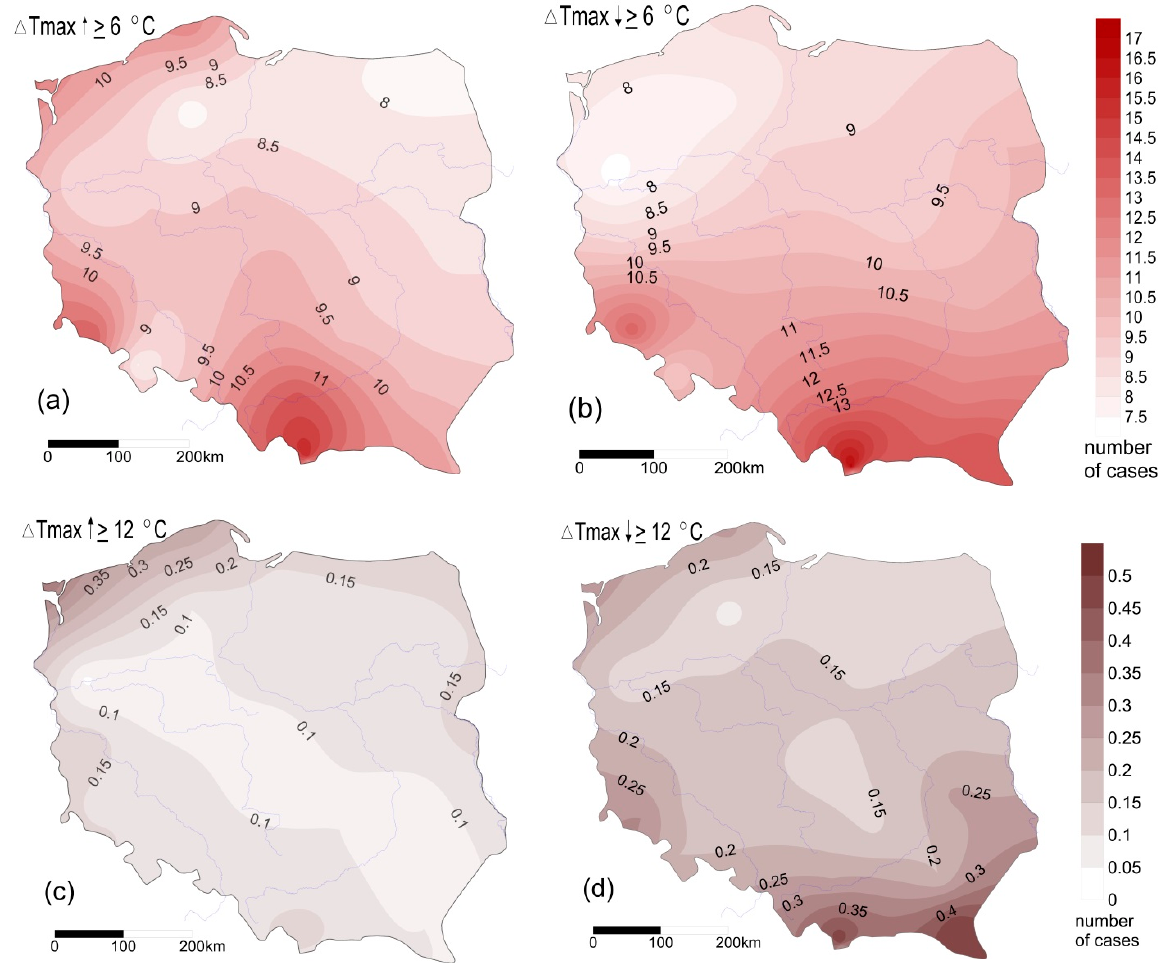
Figure 6. Spatial distribution of annual averages of large interdiurnal increases ( a ) and decreases ( b ) and very large increases ( c ) and very large decreases ( d ) in Tmax in Poland in the years 1966–2015.